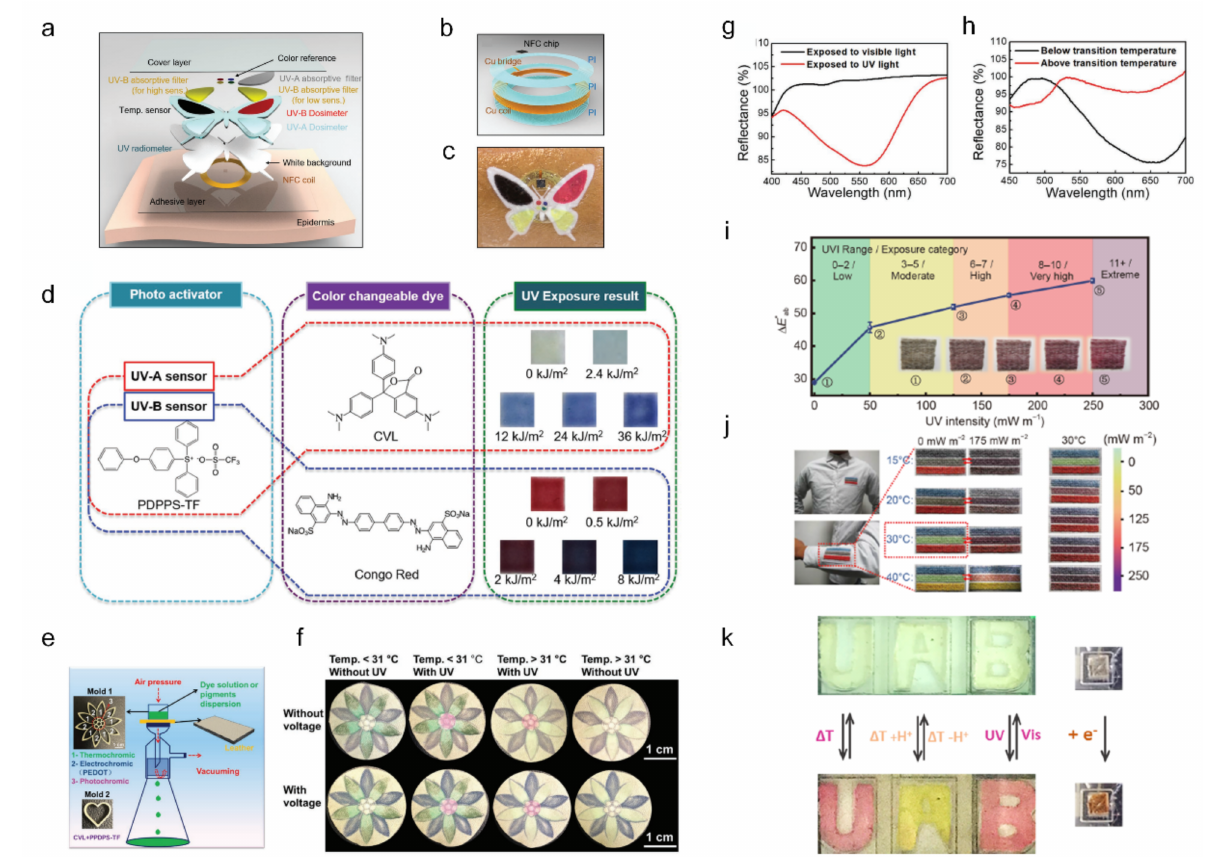
Figure 10. Multi-stimuli-responsive chromic device with UV exposure and temperature (( a – d ) adapted with permission from ref. [113], copyright 2016 Wiley-VCH Verlag GmbH & Co., ( e – h ) adapted with permission from ref. [116], copyright 2021 Wiley-VCH Verlag GmbH & Co, ( i , j ) adapted with permission from ref. [117], copyright 2021 Springer, and ( k ) adapted with per- mission from ref. [120], copyright 2021 American Chemical Society). ( a ) Schematic illustrations of the various functional layers in the multi-stimuli chromic device. ( b ) Schematic illustrations of the near-field communication electronics with a temperature sensor. ( c ) Image of the fully integrated multifunctional chromic device. ( d ) The chemical response of (4-phenoxyphenyl) diphenylsulfo- nium triflate with crystal violet lactone and Congo red for sensing in the UV-A and UV-B bands, respectively. ( e ) Schematic and pattern of the leather-based multi-stimuli device. ( f ) Thermochromic, photochromic, electrochromic demonstration of the leather-based multi-stimuli device. ( g ) Reflectance spectra of the photochromic pigment with 365 nm UV exposure (red line) and without UV exposure (black line). ( h ) Reflectance spectra of the thermochromic pigment around the transition temperature (31 ◦ C). ( i ) Color change of the chromic fibers depending on the UV intensities. ( j ) Photographs of a three-line striped textile showing different colors and monitoring different ambient UV indices and temperatures. ( k ) Multi-stimuli-responsive microfluidic device based on NO 2 BIPS@IG. Ke et al. developed cephalopod-inspired mechano-thermochromic windows